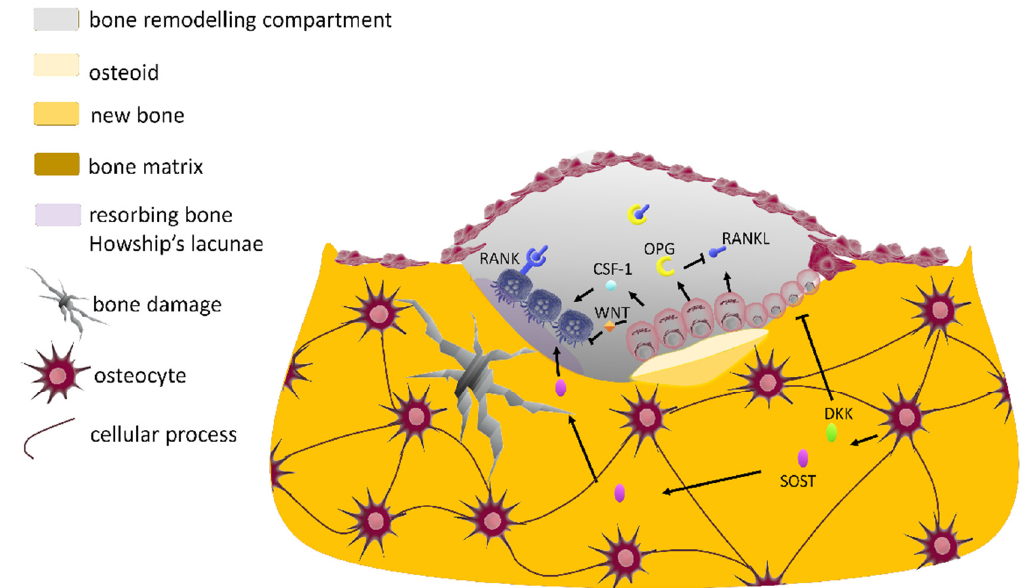
Figure 2. Molecular crosstalk in bone molecular unit (BMU): Paracrine actions of osteoblast-, osteocyte- and osteoclast- derived factors within the bone remodeling compartment. Osteoblasts respond to external signals generated by mechanically activated osteocytes or direct endocrine signals, recruit osteoclast precursors to the remodeling site, by expressing CSF, RANKL (represented in dark blue) and WNT (orange diamond), and inhibit osteoclast activity through OPG (yellow semicircle), a decoy receptor of RANKL (pictured in dark blue). Osteocyte-derived SOST (magenta oval) inhibits OB differentiation and stimulates osteoclastogenesis. The osteocyte expression levels of Wnt inhibitors (SOST and DKK (green oval)) temporally control the cycle of bone remodeling. Lines with an arrowhead indicate a positive action, and lines with a bar indicate inhibition.